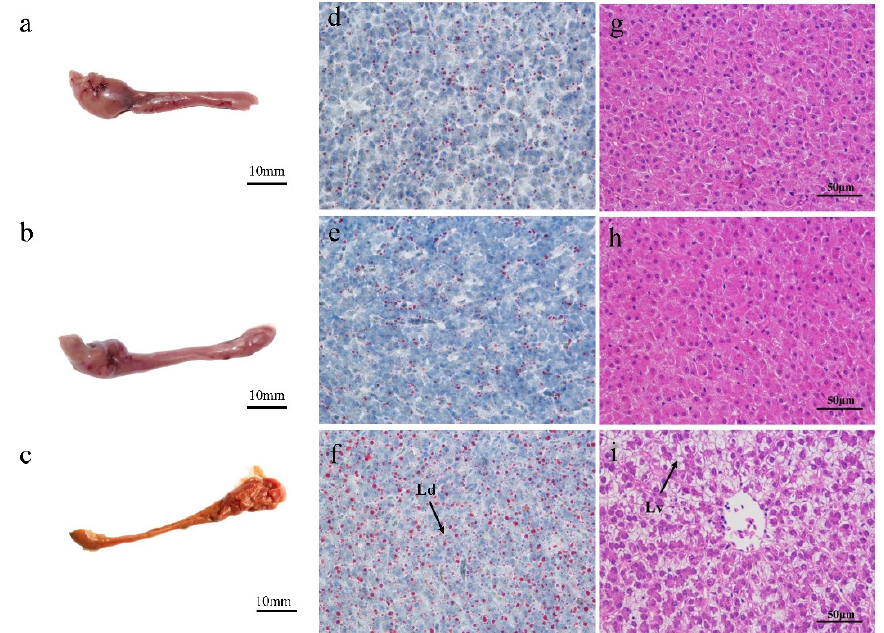
Figure 2. Effect of AGPAT2 knock-down on growth and structure of the liver in Nile tilapia. ( a – c ) Nile tilapia livers; ( d – f ) oil red O staining of liver tissues of Nile tilapia. Magnification 400×; ( g – i ) hematoxylin-eosin staining of liver tissues of Nile tilapia. ( a , d , g ) Control group; ( b , e , h ) negative control group; ( c , f , i ) AGPAT2 knock-down group. Ld: lipid droplet; Lv: lipid